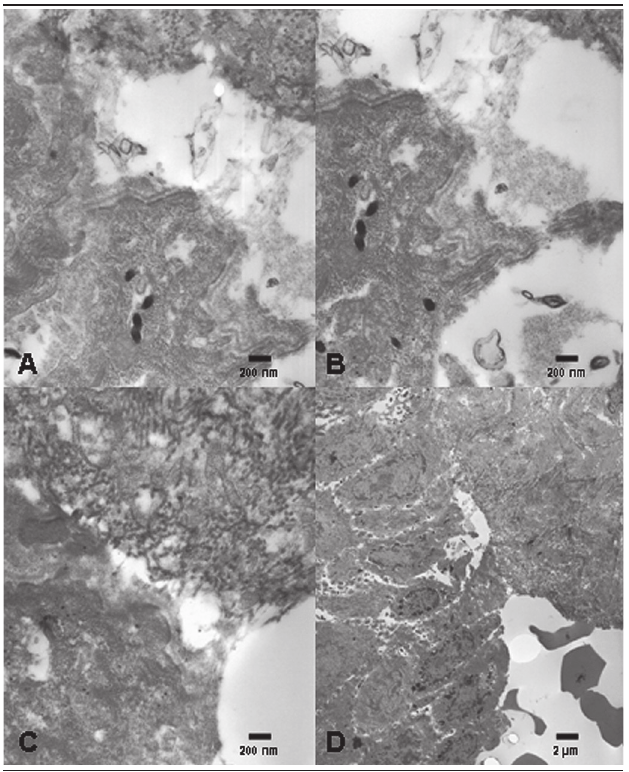
figurE 2 − Images obtained through TEM, in scales of 200 nm (A-C) and 2 µm (D), showing cleavage at the level of sublamina densa, which is consistent with the diagnosis of